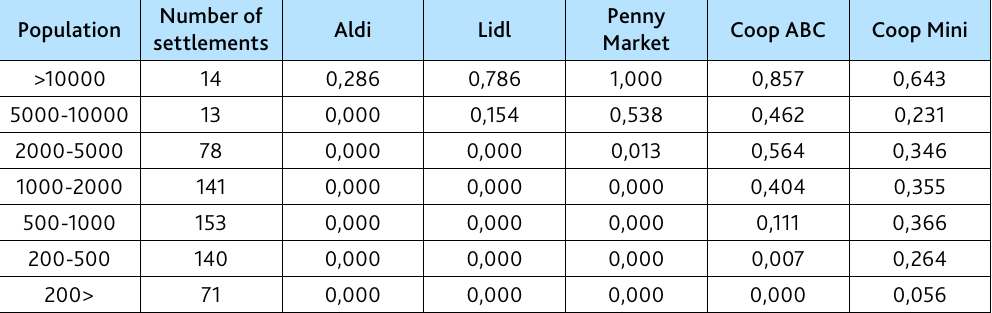
Table 4. Penetration Index of discounters and Coop stores by settlement size category, 2021 Number of Population Aldi Lidl settlements